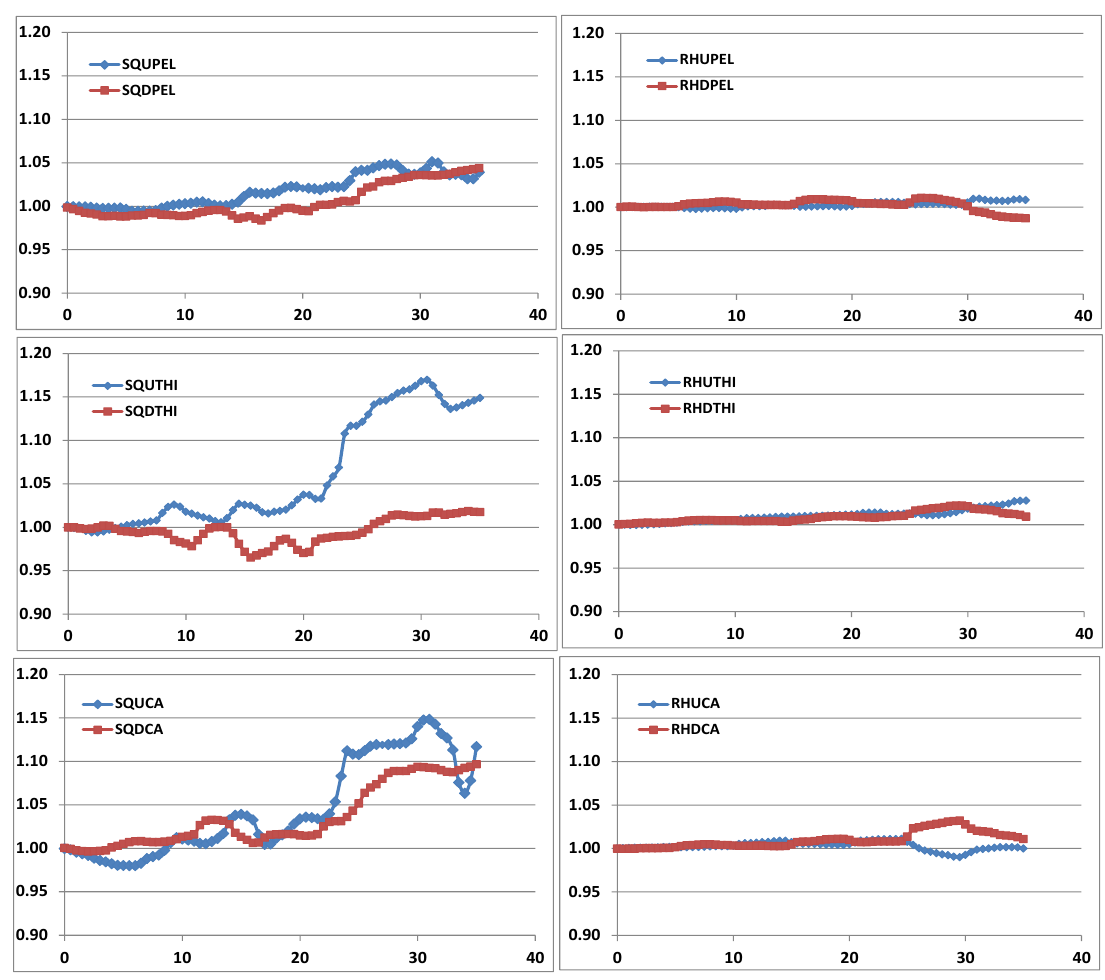
Figure 2: Squirrel and Rhesus monkey pelvic (PEL), thigh (THI), and calf (CA) lower body volume changes during short term head up and head down tilt. See text for